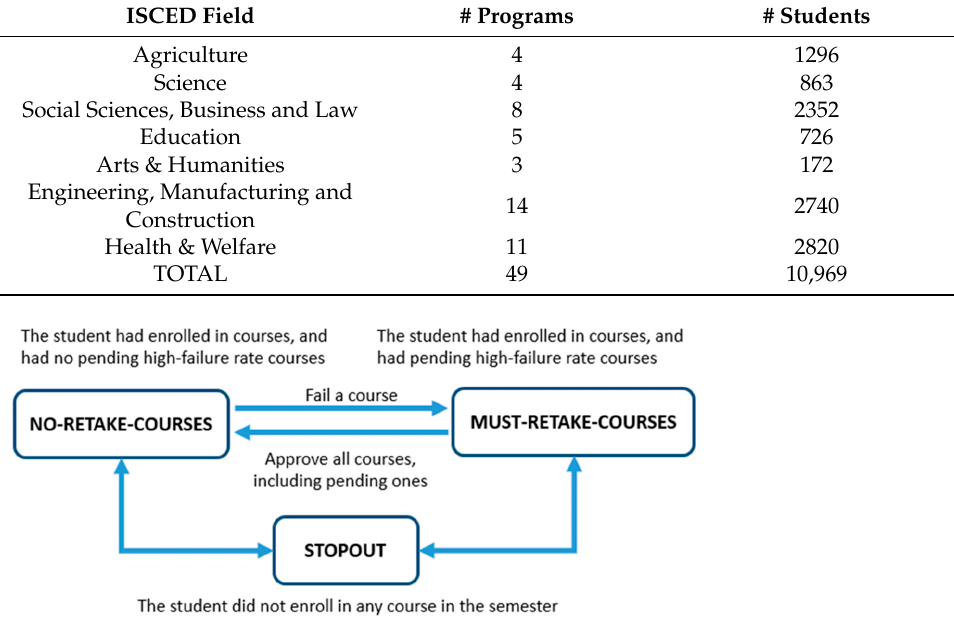
Figure 1. State diagram that shows the possible result events in the RETAKE-STOPOUT model, illustrating that all transitions between the three events are feasible between one semester and the next one. Table 3. Description of the attributes of all events contained in an event